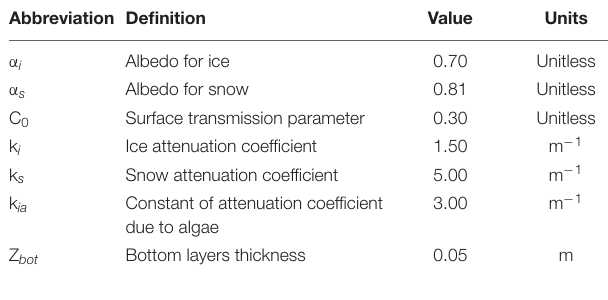
TABLE 4 | List of parameters, corresponding description, and units used in the model for light calculation (most of parameters values come from Castellani et al.,